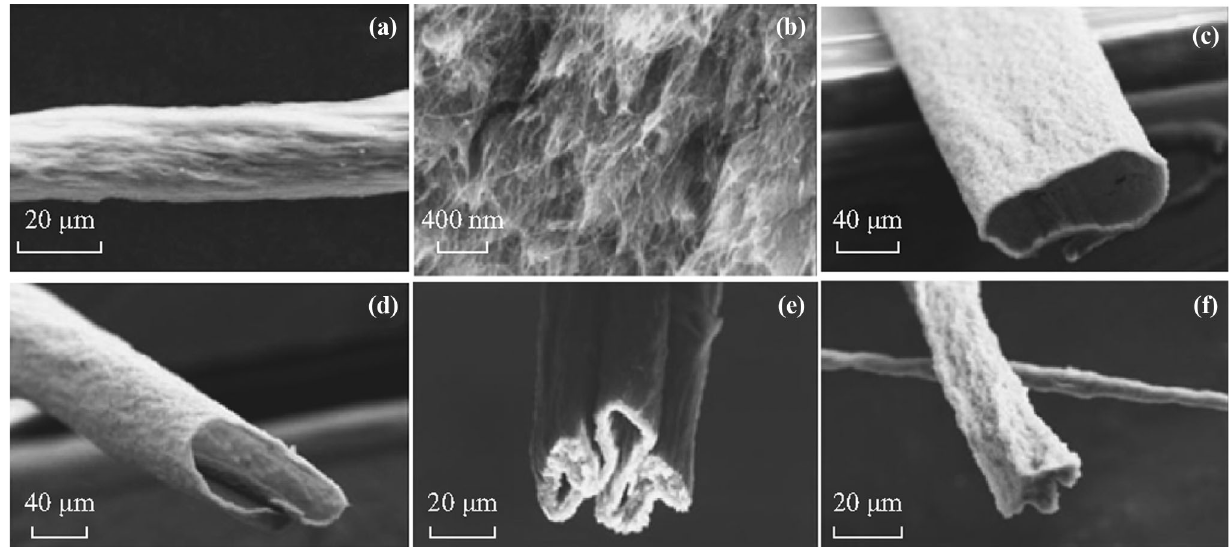
Fig. 3 SEM images of a fiber at low a and high b magnification. Cross sections of hollow ( c , d ), folded ribbon e and solid f fibers. Reproduced with permission from Ref. [19]. Copyright 2005, Wiley–VCH